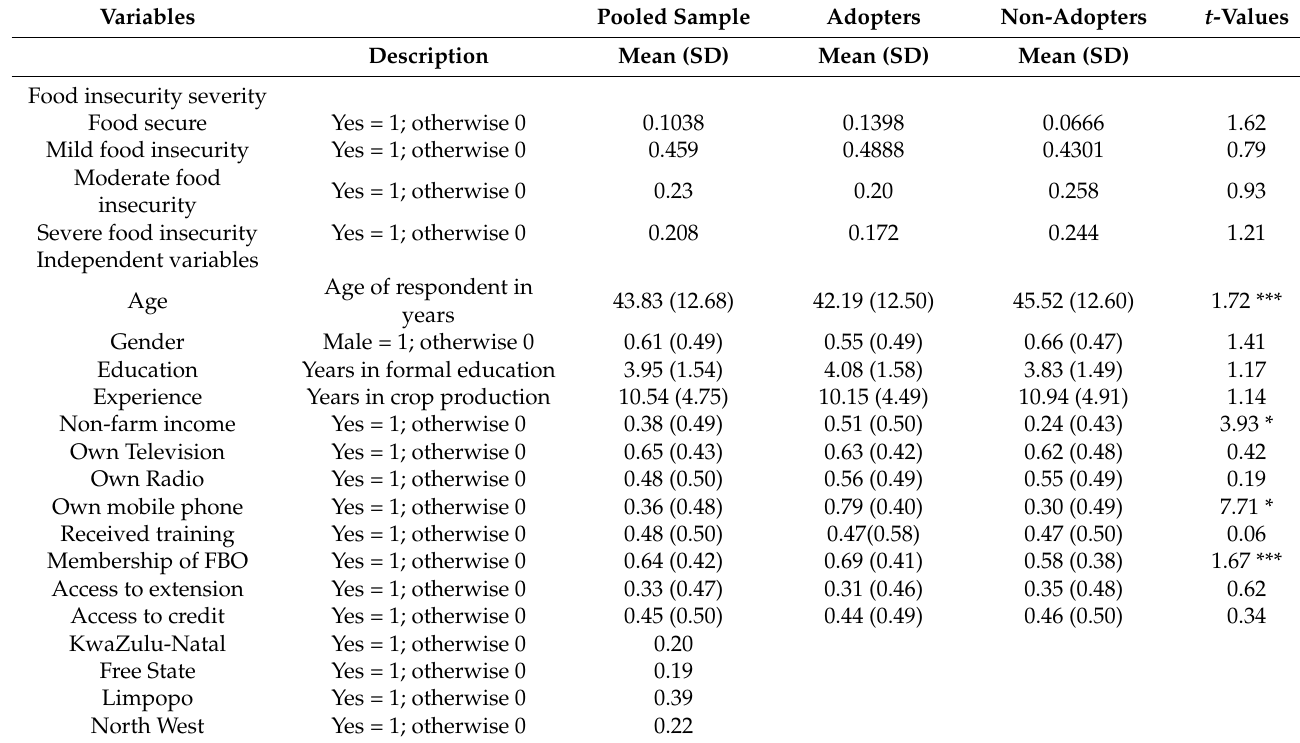
Table 1. Descriptive statistics of the farming households.